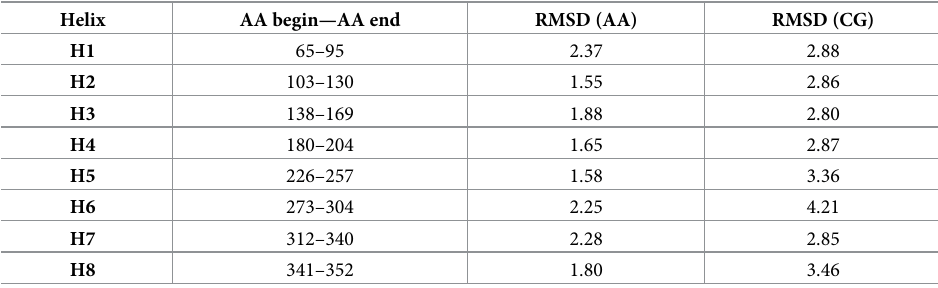
Table 2. RMSD comparison for each μ OR helix embedded in POPC membrane.